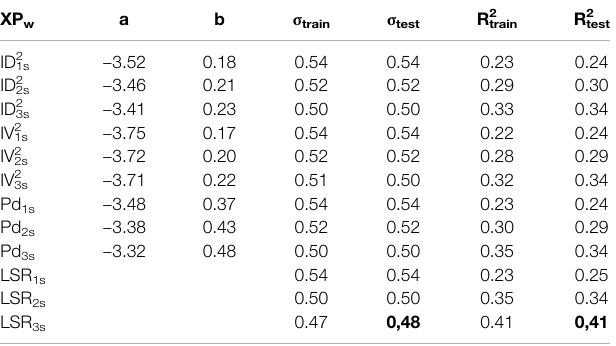
TABLE 6 | Least square regression results, Japanese dataset. TABLE 7 | ML regression results, Japanese